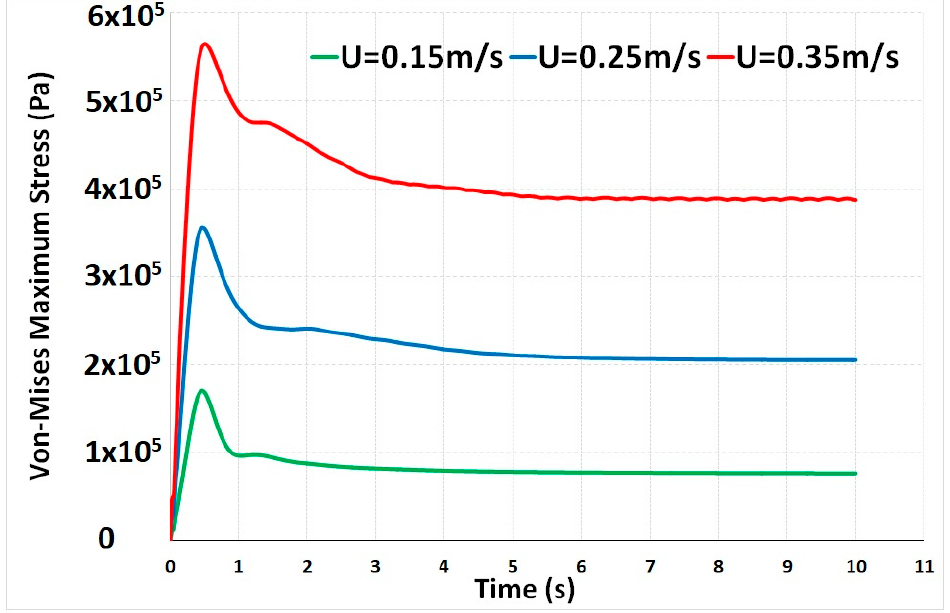
Figure 10. Variation of Von Mises maximum stress of T-shaped flexible beam between t = 0 s and 10 s.